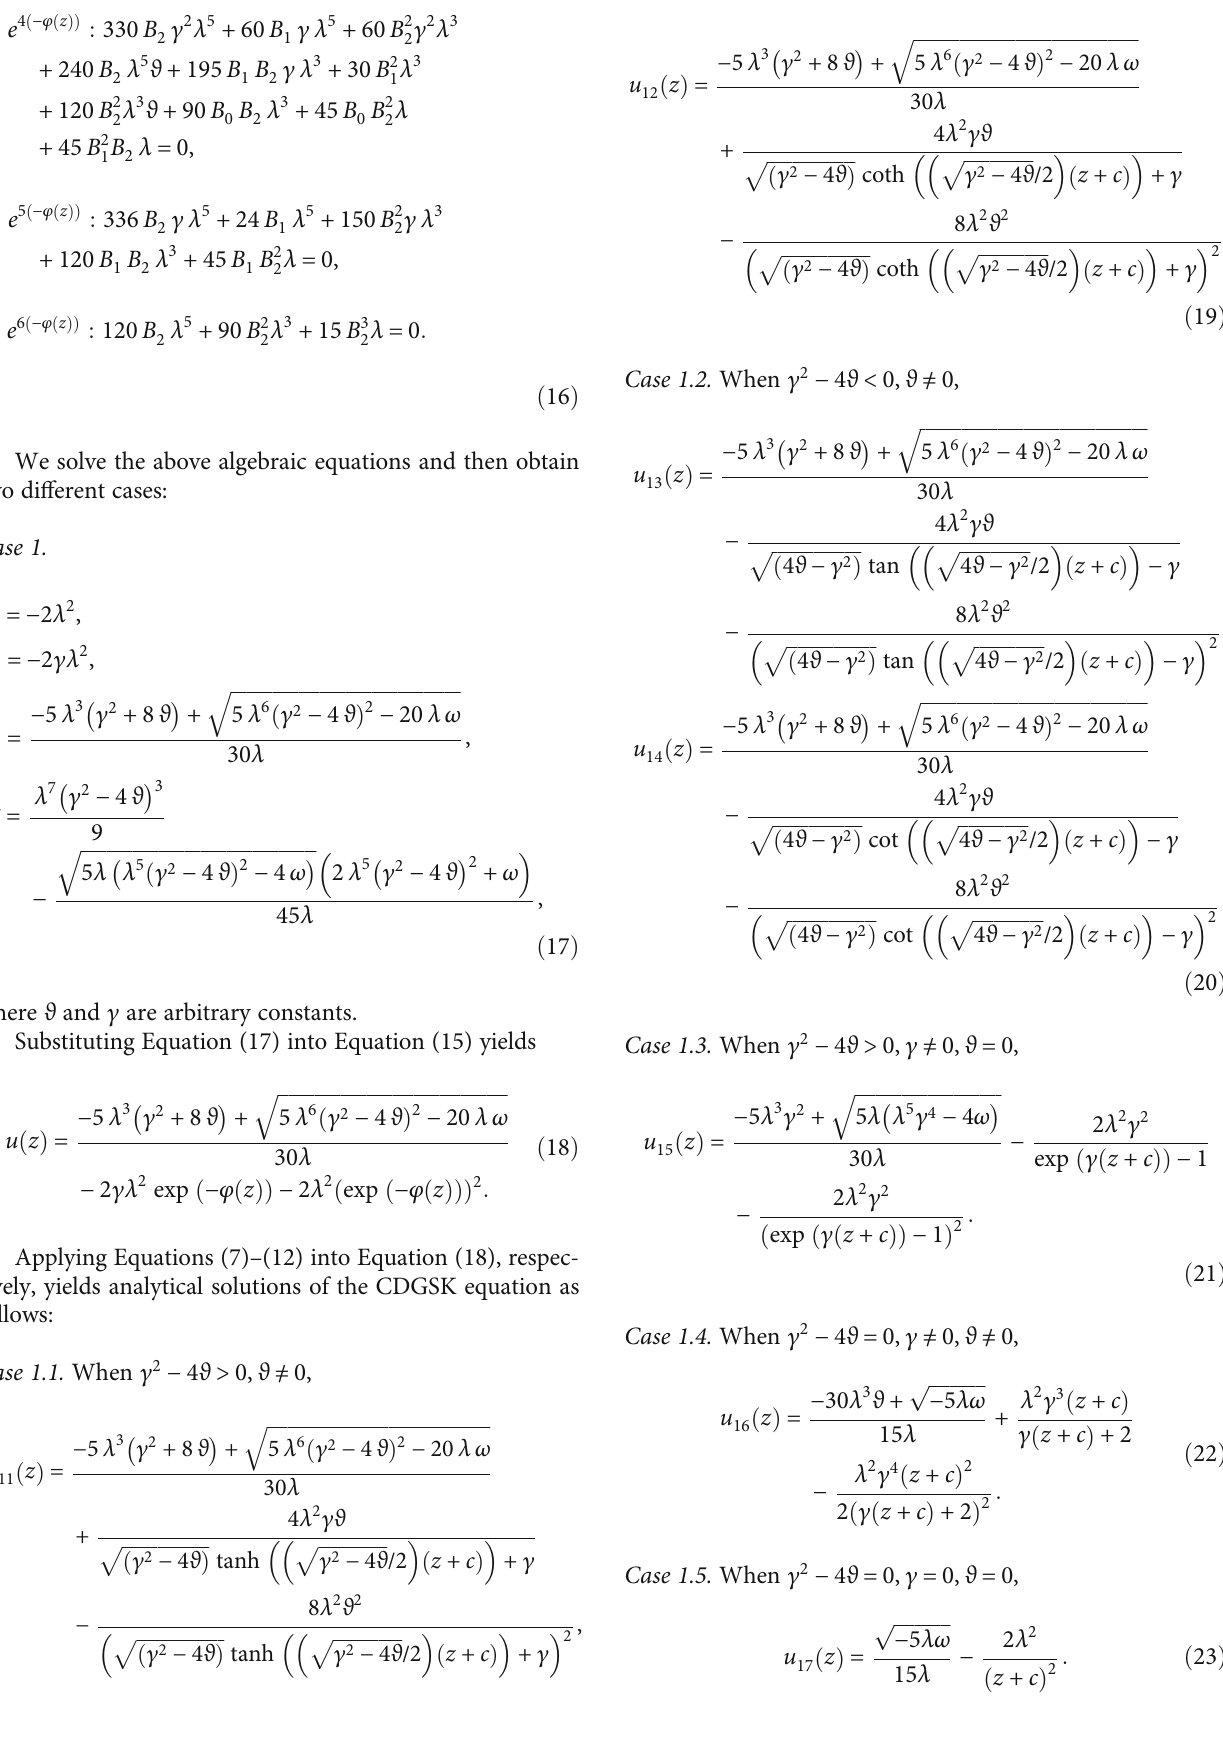
4 λ 2 γϑ p γ 2 − 4 ϑ ffiffiffiffiffiffiffiffiffiffiffiffiffiffi p γ 2 − 4 ϑ